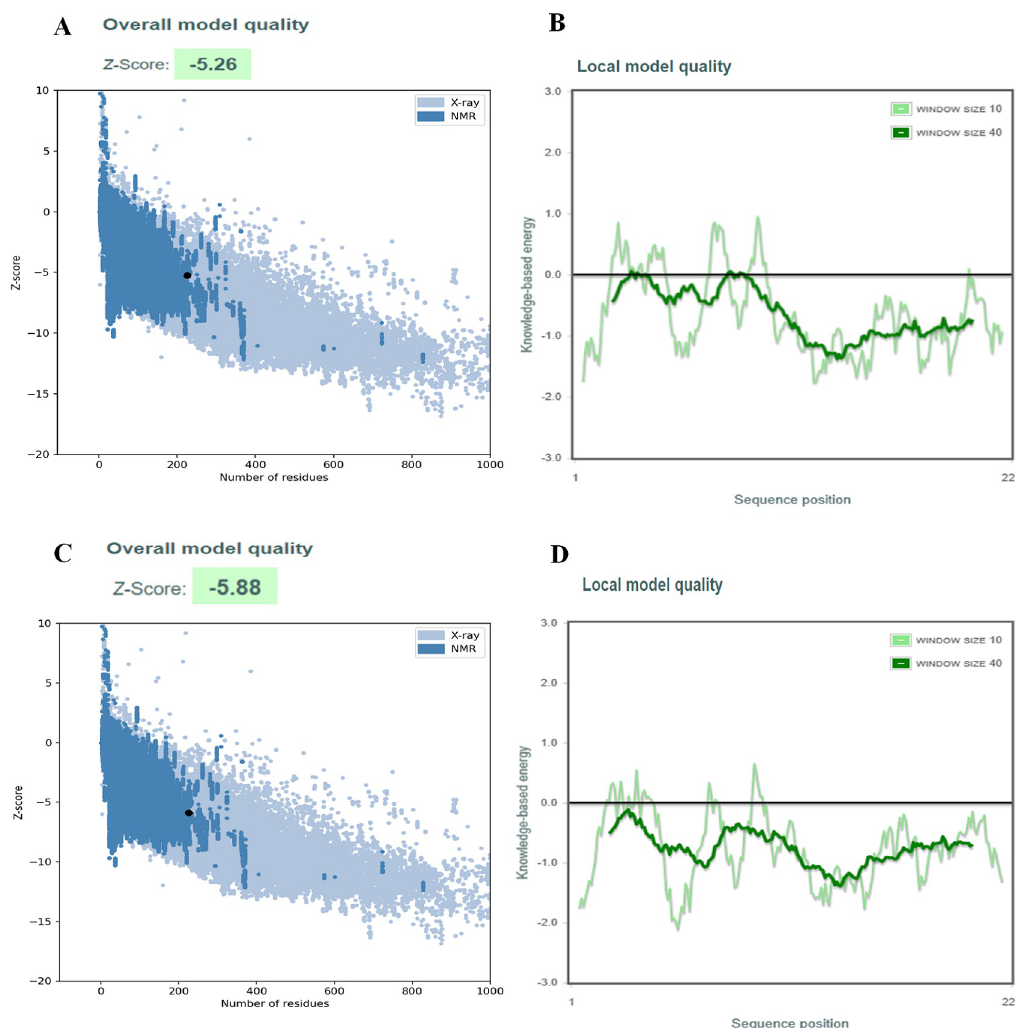
Fig 3. Evaluation of the overall model quality of 3D models of the CV777 M protein and 2013MMV M protein using ProSA web. A) Z-score plot of the 3D model of CV777 M protein. B) Plot of residue scores (Knowledge-based energy) of the 3D model of CV777 M protein. C) Z-score plot of the 3D model of 2013MMV M protein. D) Plot of residue scores of the 2013MMV M protein. The black dot in A and C represents the 3D model of the M